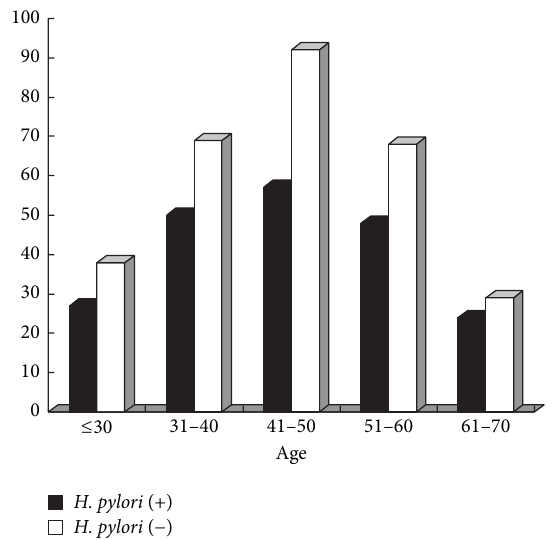
Figure 2: Age-related prevalence ofIBS-Din cases with and without H. pylori